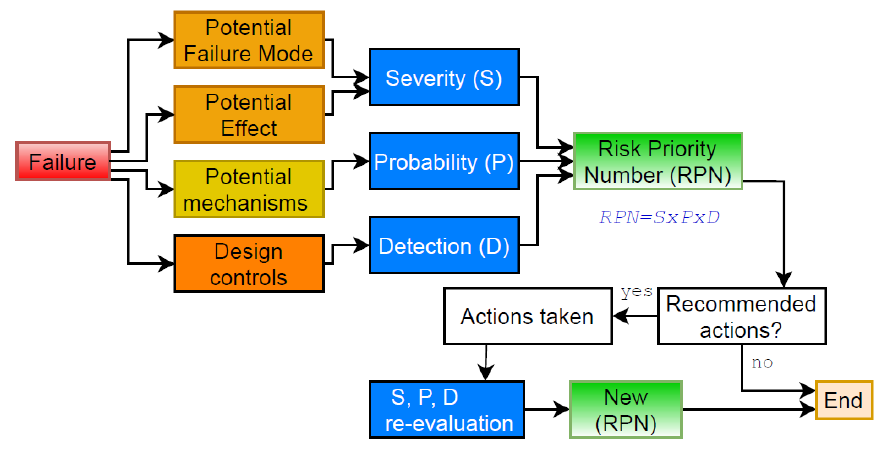
Figure 4. Typical FMEA pathway .